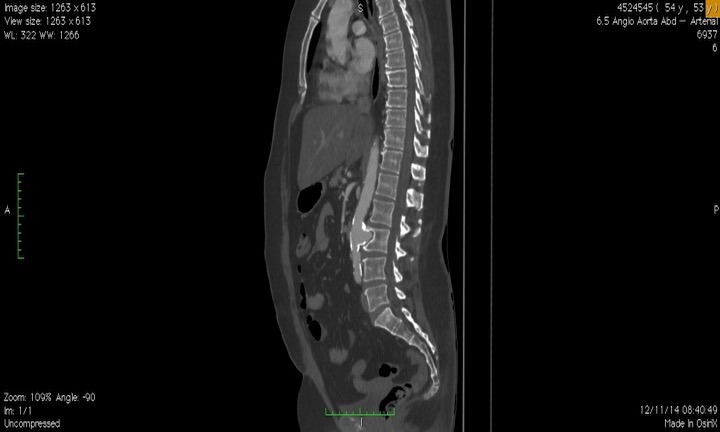
Preoperative sagittal angiotomography showing aortic aneurysm with erosion of lumbar vertebra.